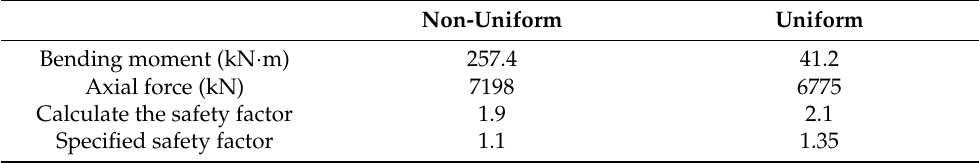
Table 4. S1ZK0 + 660 m section lining safety factor calculation value, according to Method